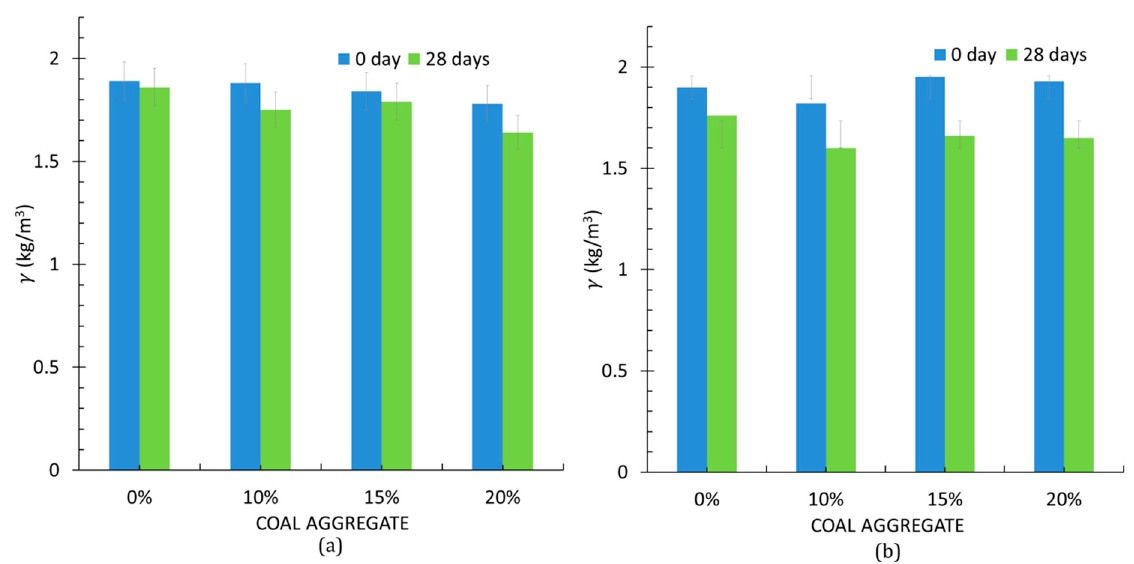
Figure 9. ( a ) Specific weight without lime, ( b ) Specific weight with 4% lime.